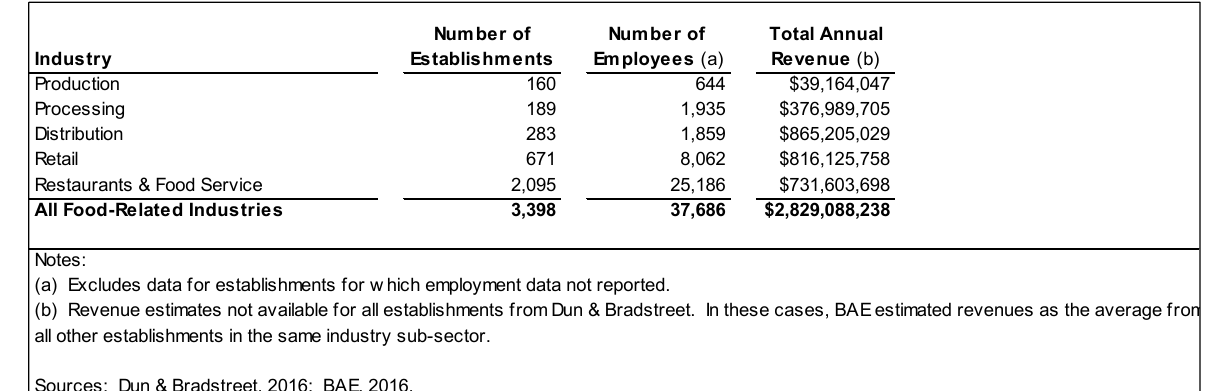
Table 3. Food-Related Establishments, Employees and Revenue, by Industry